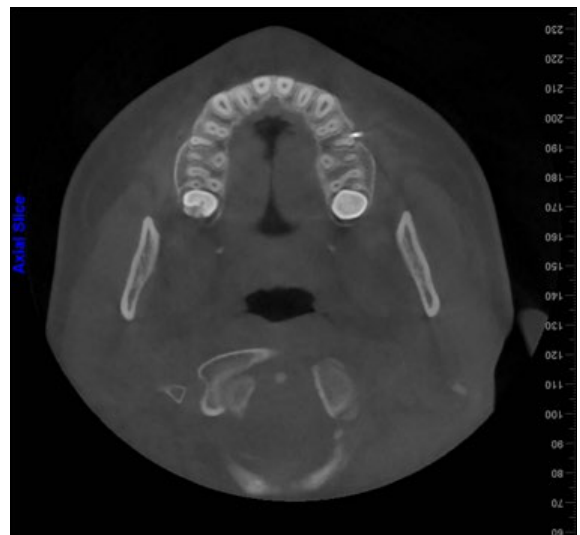
Figure 8. Bone remodeling around roots of maxillary central